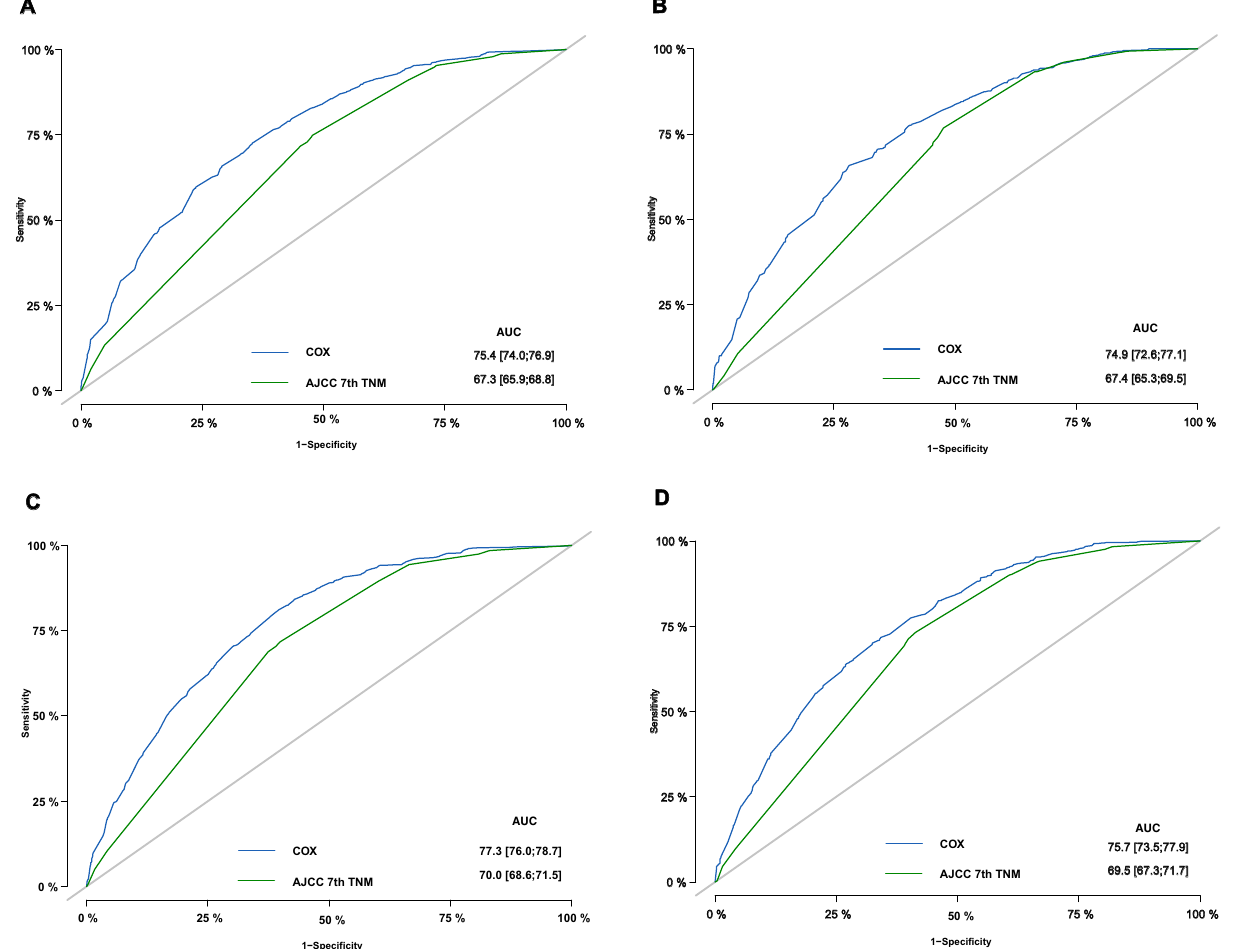
Figure 5. Receiver operating characteristic curve analysis in the training and validation cohorts of the nomograms and 7th edition AJCC-TNM staging system for predicting 1-, 2-, 3-, and 5-year OS. OS, overall